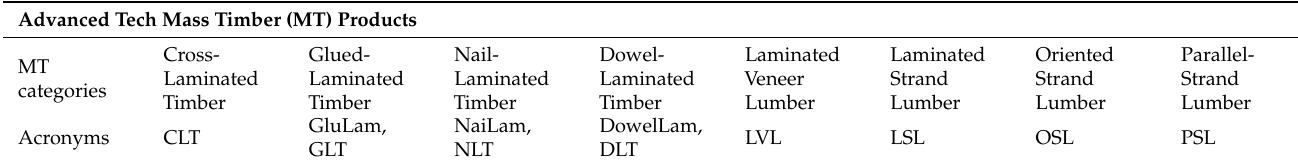
Table 5. Some examples of readily available high-tech mass